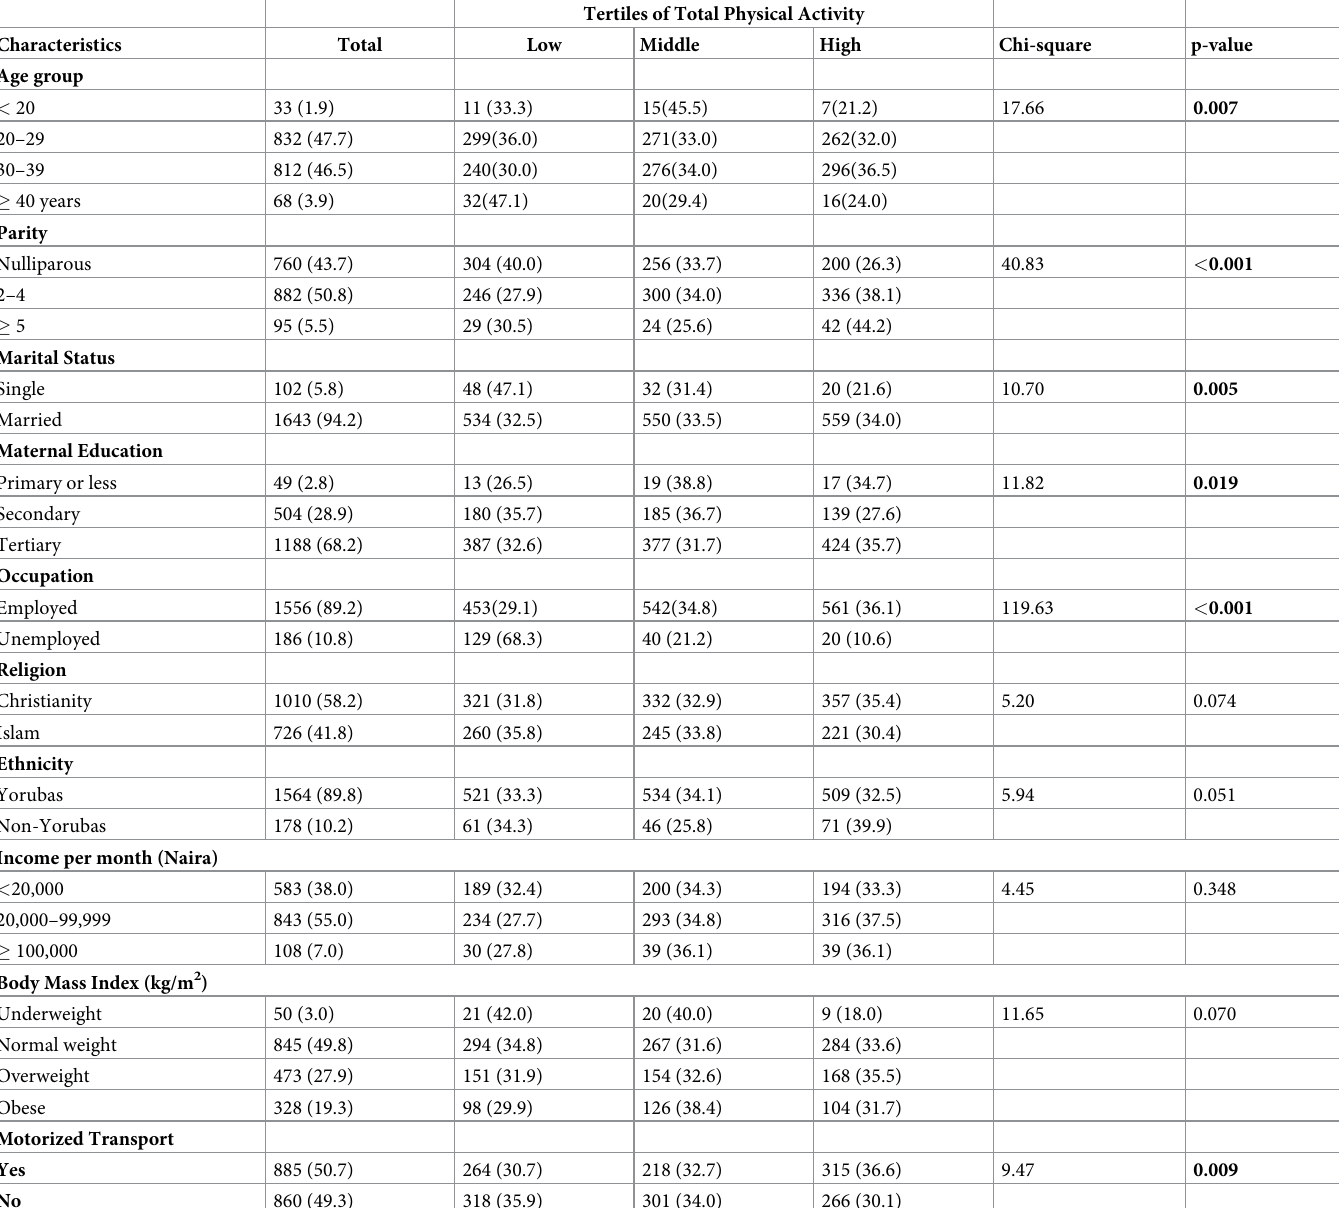
Table 1. Characteristics of pregnant women according to tertiles of total physical activity in the Ibadan Pregnancy Cohort Study. Tertiles of Total Physical